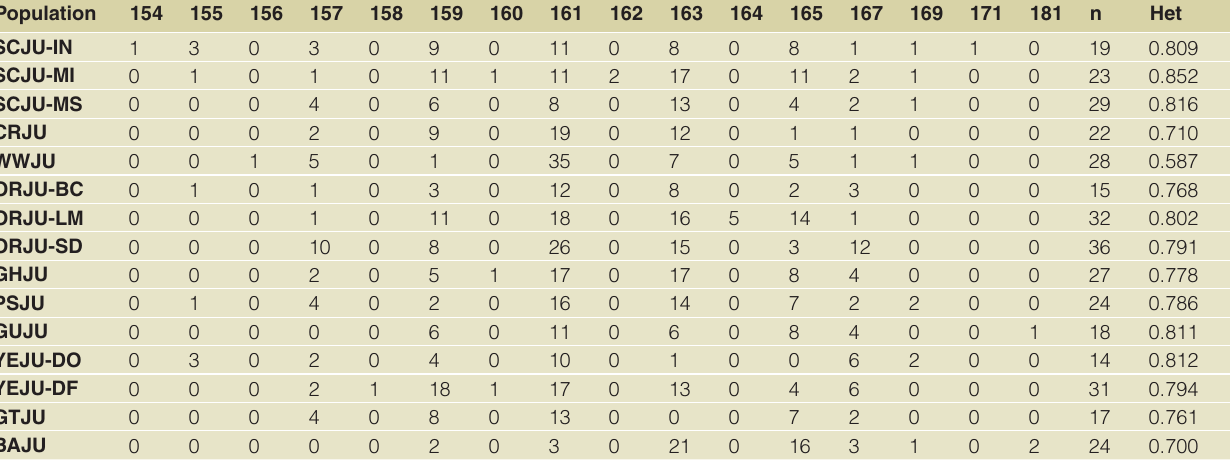
Table 3. Distribution of ADCYAP1 allele length within each population. Table lists the number of individuals from each population possessing each of the identified ADCYAP1 alleles. Number of individuals genotyped is indicated as “n” for each population. Het = calculated heterozygosity for the population. Other abbreviations follow from Table